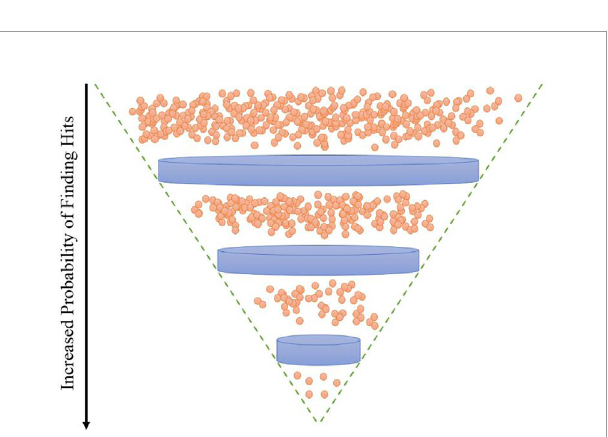
FIGURE 5 | DeepMalaria fi nds potent hits with higher recall. 87.85% for hits with inhibition of 50% or more, 100% for nanomolar active hits.